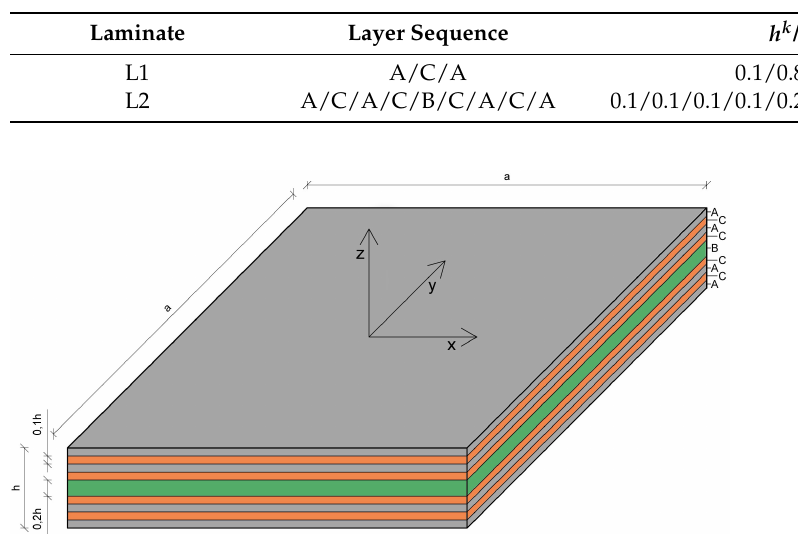
Table 3. Example 2: Stacking sequence.